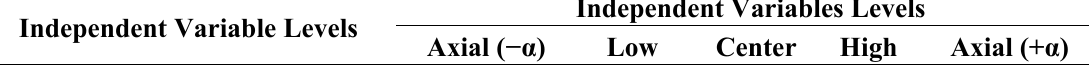
Table 3. Level of independent variables established according to central composite design (CCD).